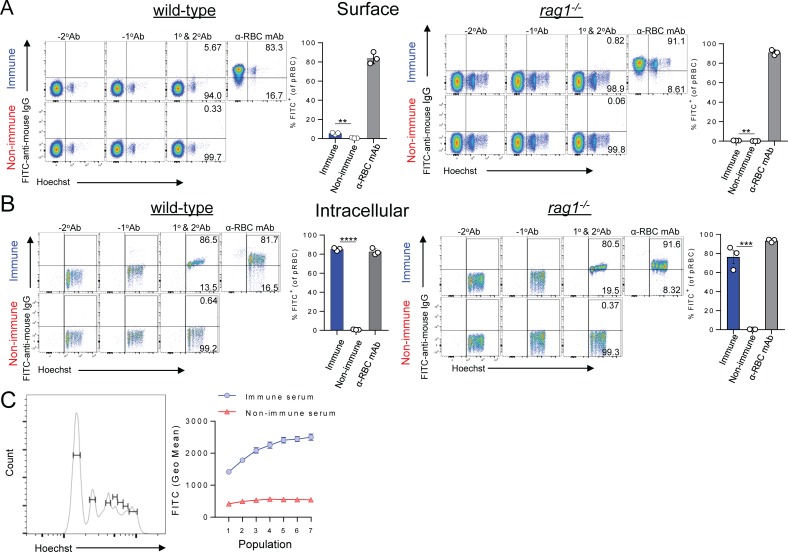
Infection-induced Py17XNL-specific IgG binds poorly to intact pRBC, but strongly to permeabilised schizonts.Detection of in vitro deposited IgG from immune or non-immune control serum either (A) on the surface of RBC, or (B) inside RBC from Py17XNL-infected wild-type mice and rag1-/- passage mice after fixation/permeabilisation. Graph shows percentage of pRBC binding to mouse IgG after fixation/permeabilisation. (C) Representative histogram showing gating for identifying Py17XNL pRBC from wild-type mice containing different numbers of merozoites using Hoechst. Graph shows variation in geometric mean fluorescence intensity of in vitro IgG deposition inside fixed and permeabilised pRBC according to DNA content, when incubated with immune or non-immune control serum (assessed in triplicate); two-tailed Students T-test, p = 0.0004. Data in (A-C) are representative of six independent experiments for pRBC from WT mice, and two independent experiments using rag1-/- passage mice.